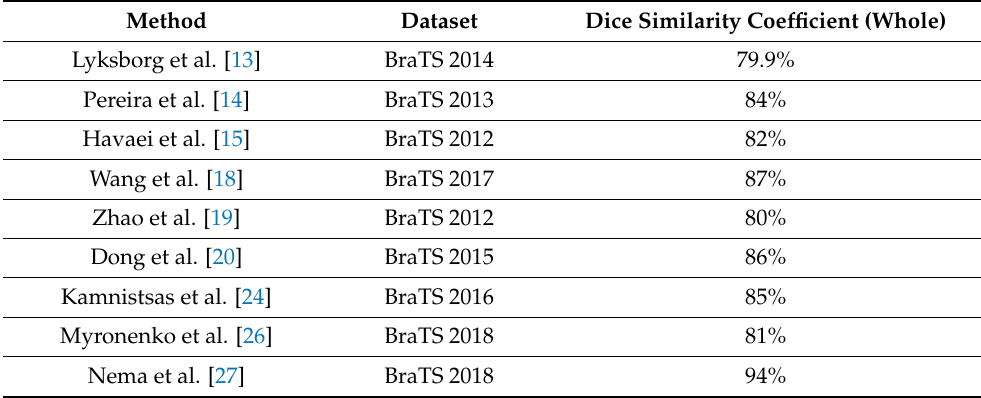
Table 1. Summary of related works’ performance results.